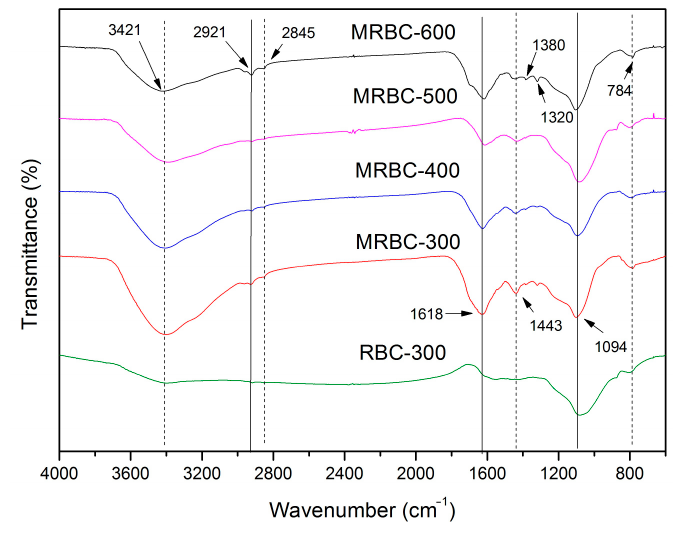
Figure 4. FTIR spectra of MRBCs and RBC.